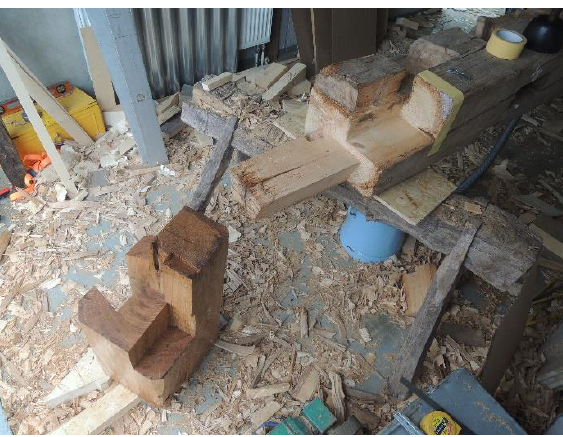
Figure 8. The new part before being inserted by a ledge joint.